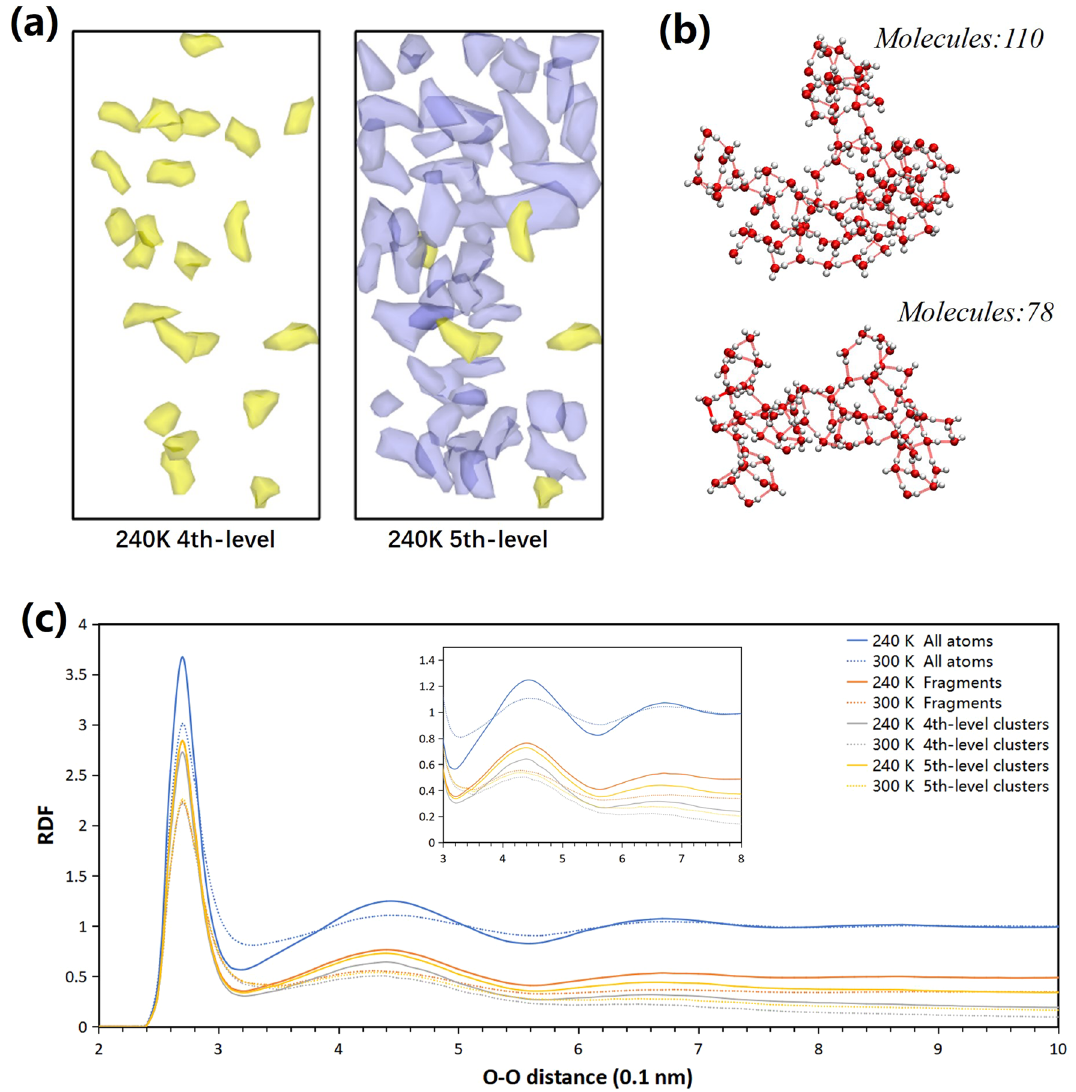
Figure 5. The spatial distribution of the 4th- and 5th-level clusters at 240 K and radial distance functions of the 4th- and 5th-level clusters at 240 K and 300 K. ( a ) 4th- and 5th-level large clusters that have more than 30 molecules at 240 K drawn by Ovito 62 . ( b ) The ball-and-stick model of characteristic clusters drawn by VMD 1.9.1 63 . ( c ) The radial distance functions of the 4th- and 5th-level clusters at 240 K and 300 K. The radial distance functions are calculated in the selected oxygen